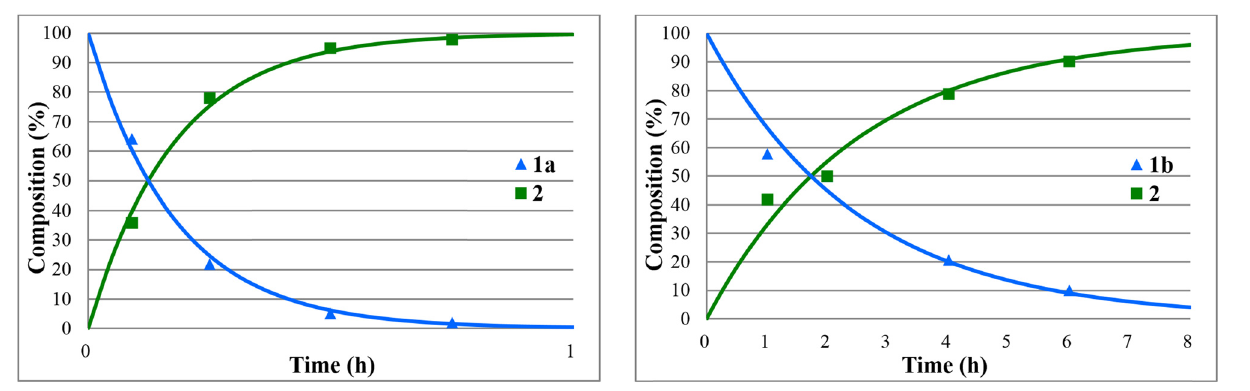
Figure 9: Concentration pro fi le for the components ( 1a and 2 ) during the alkaline hydrolysis of methyl diphenylphosphinate ( 1a ) at 50°C, in the presence of 1.1 equiv. NaOH. The R 2 measure of goodness of fi t is 0.991.